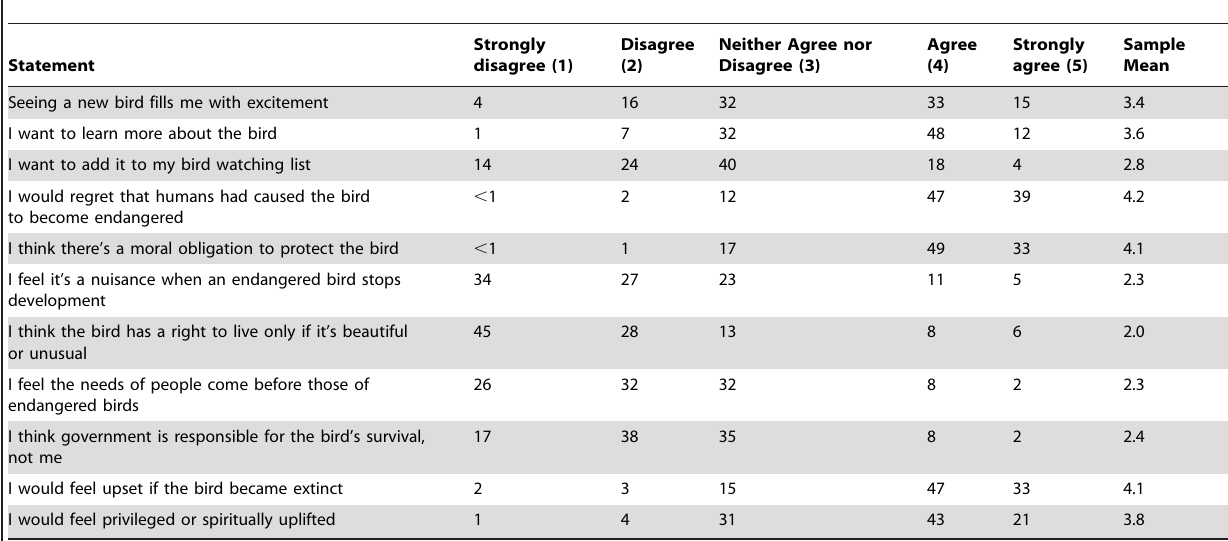
Table 3. Responses (in %) to a series of statement questions asking: ‘Thinking about how you would feel if you knew you had seen an endangered bird, how much do you agree or disagree with these statements?’